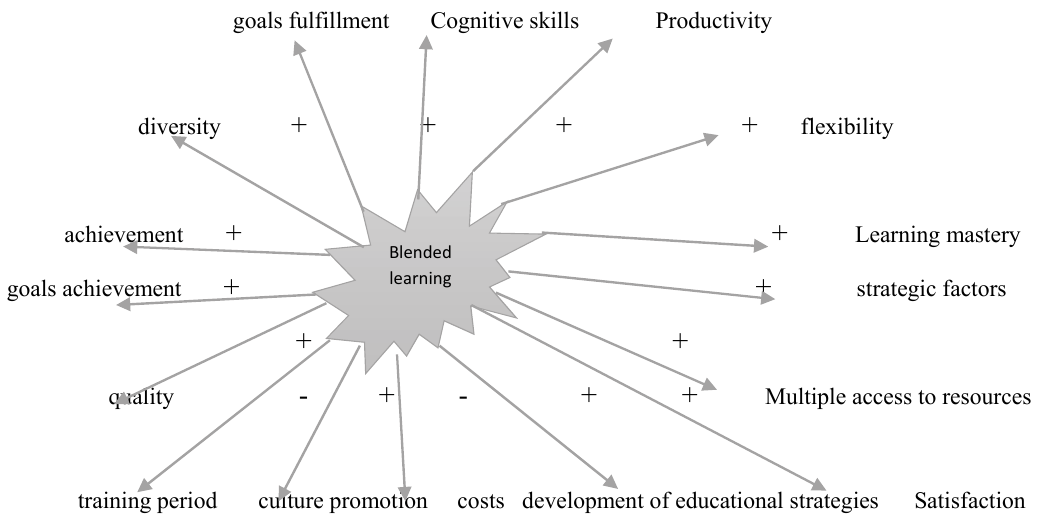
Fig. 1. The impact of blended learning on its relevant